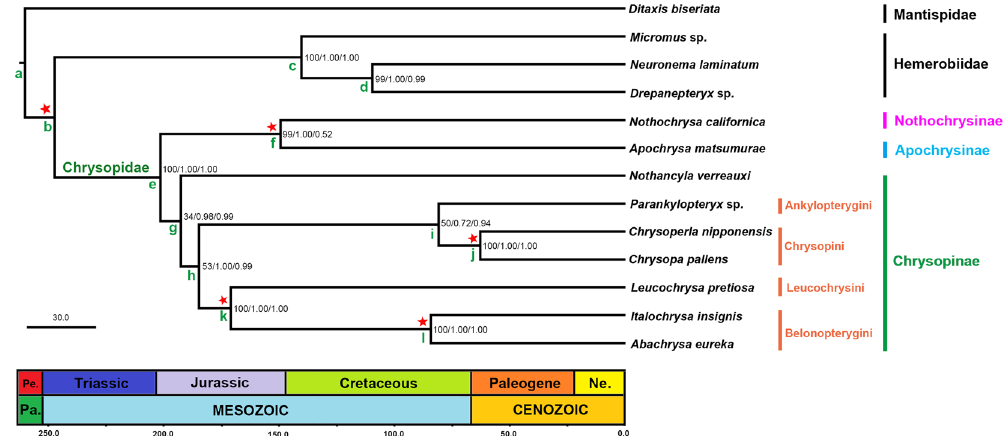
Figure 4. Phylogenetic hypothesis of green-lacewings obtained with Bayesian inference and maximum likelihood based on mitogenomes, divergence time estimates calculated with Phylobayes are also featured. Branch support values are featured at their respective node in the following order: bootstrap values/posterior probabilities (resulted under partition-specific models)/posterior probabilities (resulted under CAT model). Letters on nodes correspond to the age estimates featured in Table 2. Scale units are in millions of years. Stars indicate the node with fossil calibration and letters are used as arbitrary